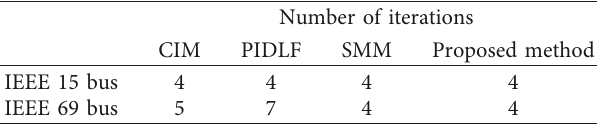
Table 7: Comparison of the performance of the proposed